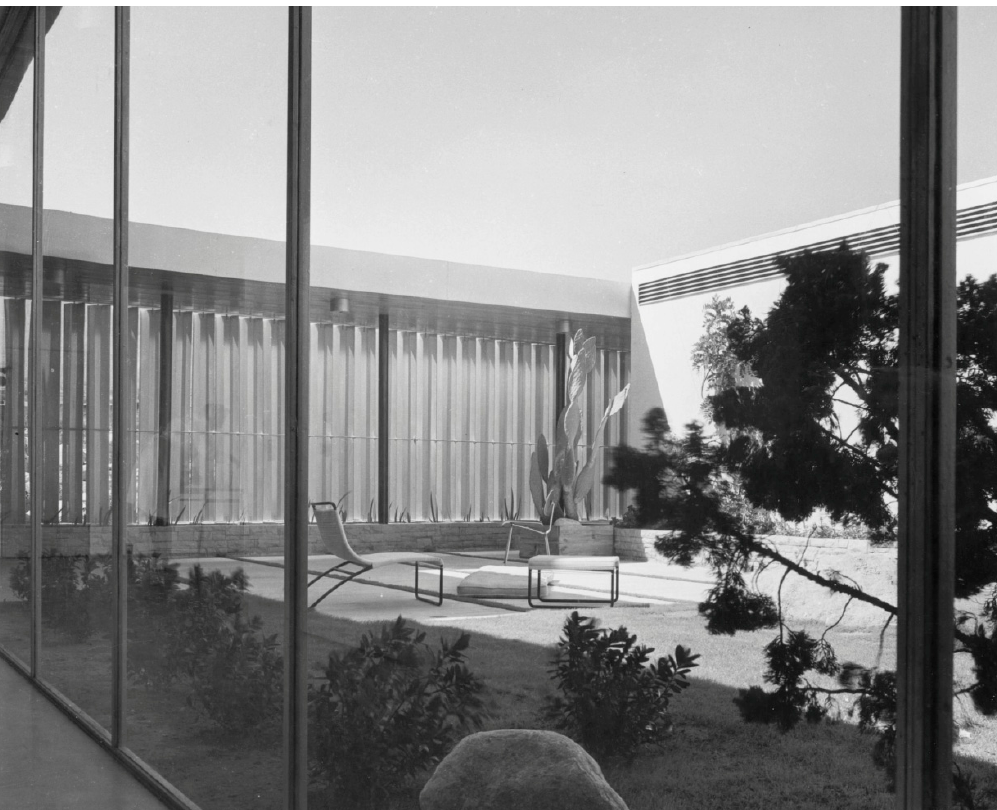
Figure 10. Richard Neutra, Kaufmann Desert House, Palm Springs, 1946–1947. Movable aluminum louvers protecting the courtyard between the dining area and the guestrooms from winds and sandstorms. (Detail of photo by Julius Shulman, job 093-34, © J. Paul Getty Trust. Getty Research Institute, Los Angeles, 2004.R.10).